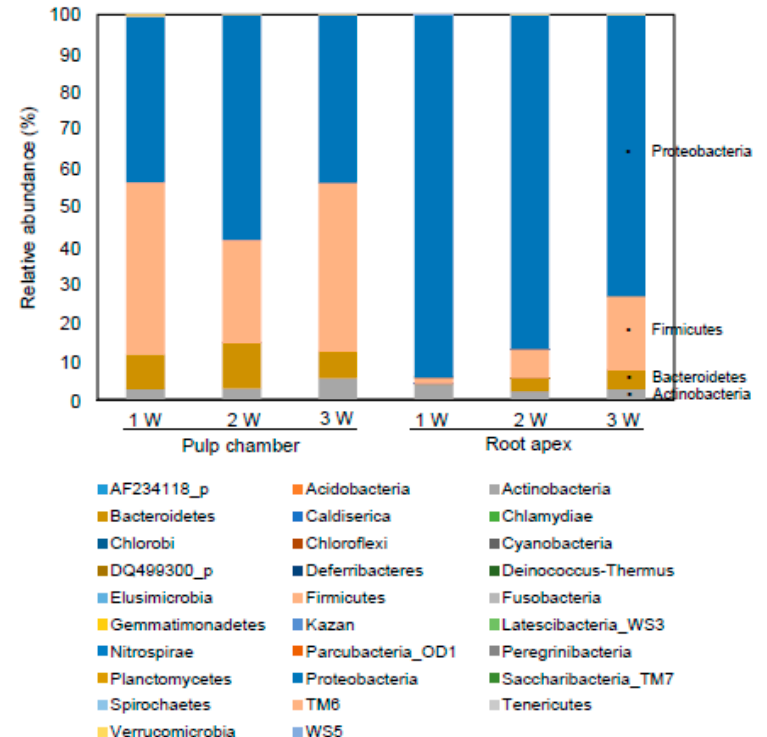
Figure 4. Relative abundance of bacterial phyla identified in the pulp chamber and the root apex.